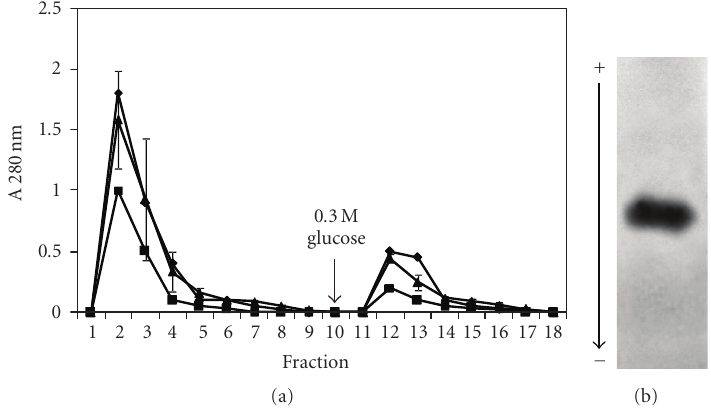
Figure 4: A ffi nity binding of F40–60 on FMZAG-12L . Aliquots of 18mg ( (cid:2) ), 10mg ( • ) and 5mg ( ◦ ) were incubated with the magnetic particles and eluted with bu ff er and glucose (arrow). (a) Fractions (1mL) were collected and their absorbance at 280nm measured (a). Each bar represents the mean ± SD of four experiments using the same FMZAG-12L particles when 10mg of F40–60 were used. (b) Electrophoresis to native and basic protein (100 μ g) from the 10 mg protein F40–60 profile of the 10th and 11th fractions was stained with Amido